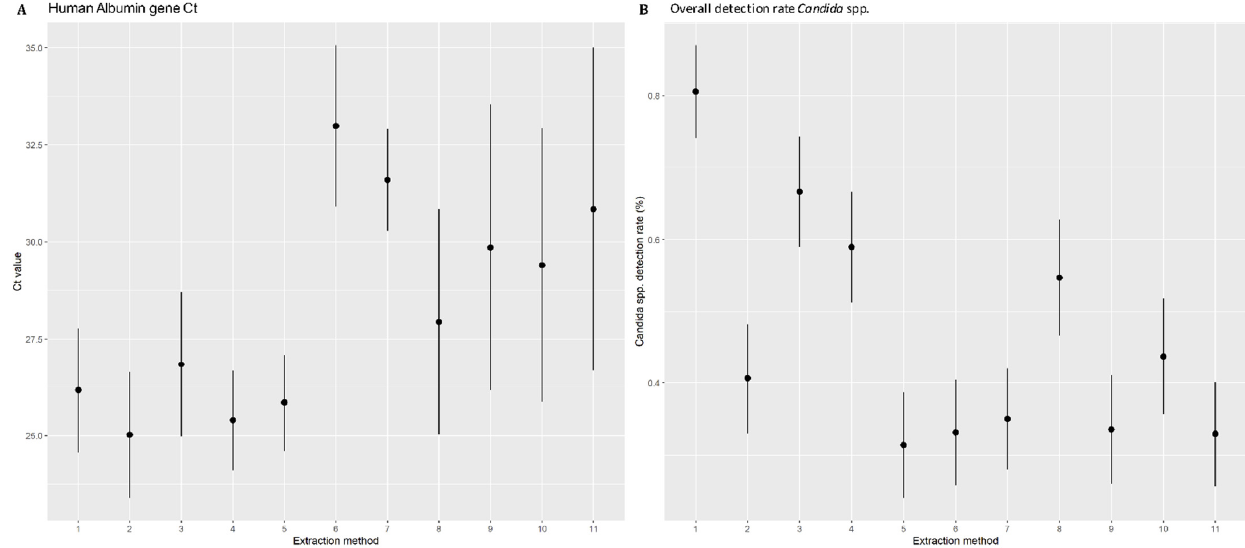
Figure 1. ( A ) Distribution of human albumin gene Ct according to the extraction methods tested. The means of the Cycle threshold and their 95% confidence interval are shown. ( B ) Distribution of the Candida species detection rate (in percentages) according to the extraction methods tested. The detection rates (in percentages) and their 95% confidence interval are shown.